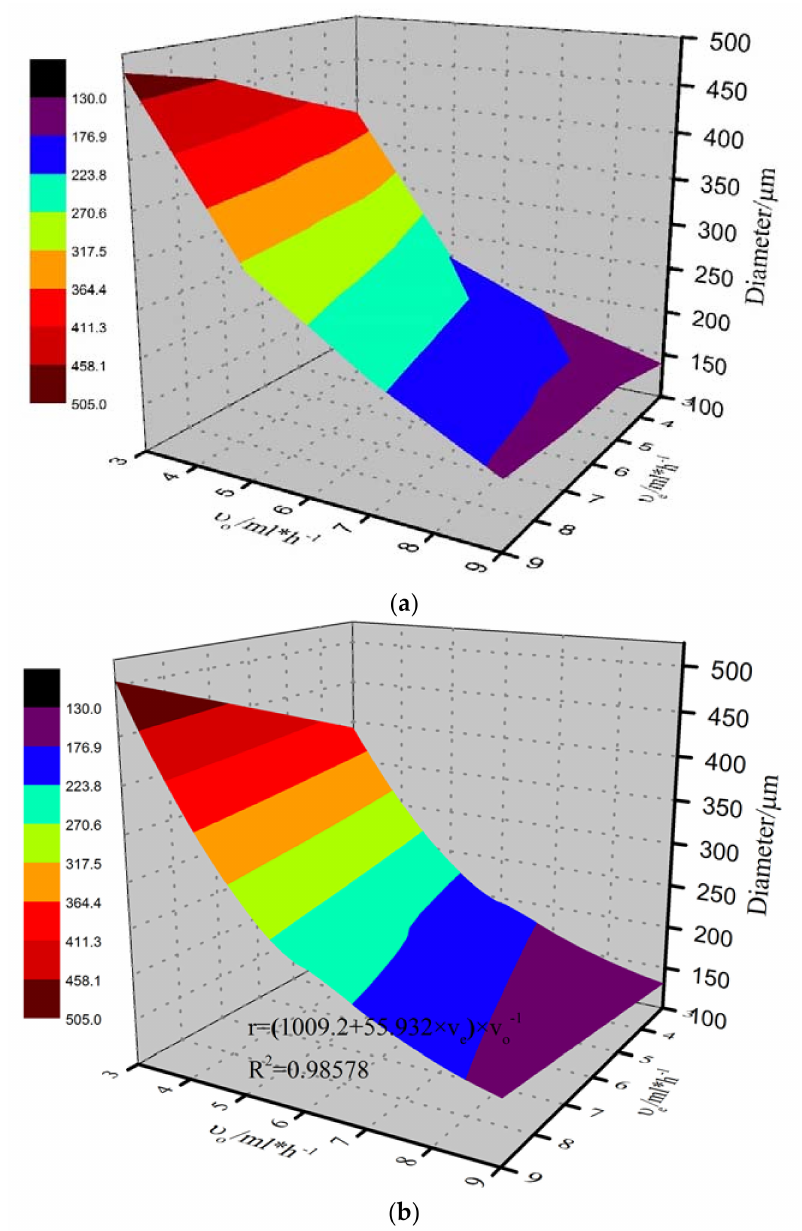
Figure 7. Three-dimensional experimental image ( a ) and fitting image ( b ) of diameter of the microcapsules versus flow rate of continuous phase (oil) and dispersed phase (alginate